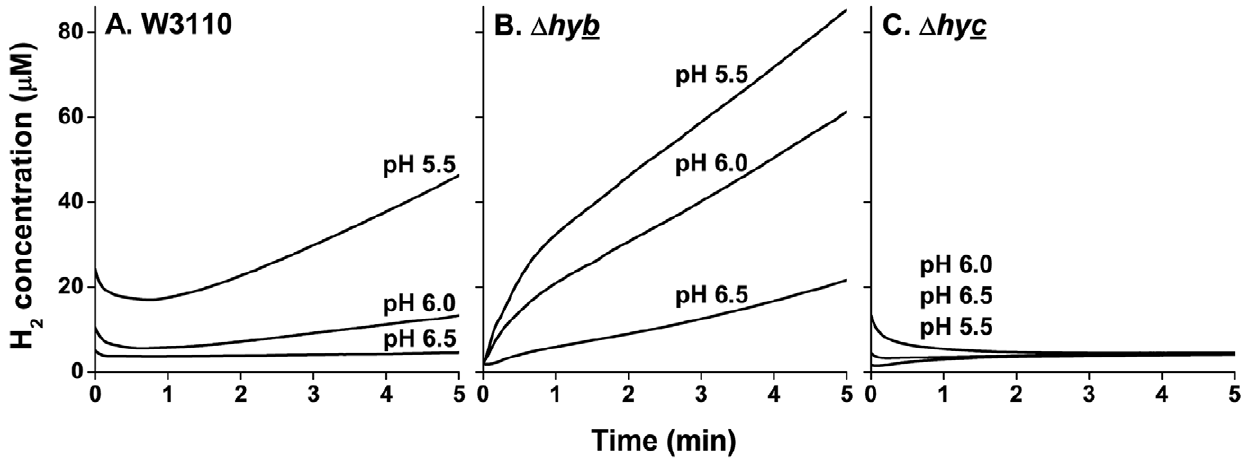
Figure 1. Effect of pH on the H 2 production by W3110, D hybC , and D hycE . The lines represent traces of H 2 concentration as a function of time. Before time 0, the cultures were sparged with 100% N 2 in order to eliminate any residual H 2 in the culture. Anaerobic cultures of W3110 ( A ), D hybC ( B ), and D hycE ( C ) were grown to log phase at pH 5.5, pH 6, and pH 6.5 and assayed for H 2 production as stated in the Materials and Methods. Lines are representative samples of n=3.